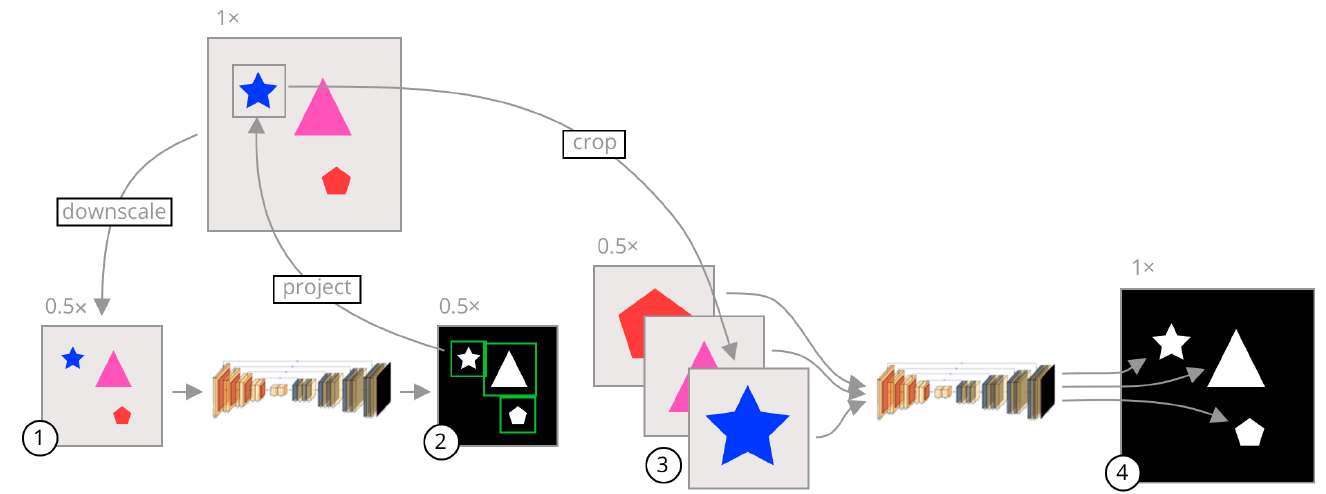
Figure 1. A visual summary of our approach. The gray images are the input images while the black images are segmentation mask outputs from the models. The shapes on the images are only representative, and the inputs can be any image where several objects need to be segmented. The arrows represent image operations. (1) An image is uniformly downsampled from its original resolution. (2) A rough segmentation is predicted by a neural network, and the bounding box of each connected component is calculated. (3) The bounding boxes are scaled to the original image space and crops of the input image are taken in the original resolution and scaled to a common input size. (4) Each crop is segmented separately by a second neural network specifically trained on cropped images. These crops are fused together to form a final segmentation in the original high